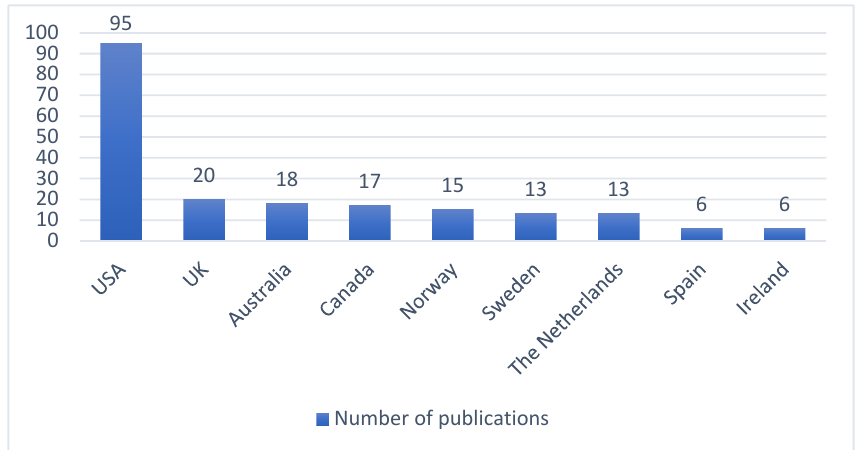
Figure 3. Publications by country of origin (2005–2020) (229 publications). Other countries: France (4), New Zealand (4), Taiwan (3), Germany (3), Switzerland (3), Denmark (2), Japan (2), China (Hong-Kong) (2), Belgium (1), Singapore (1), Brazil (1).